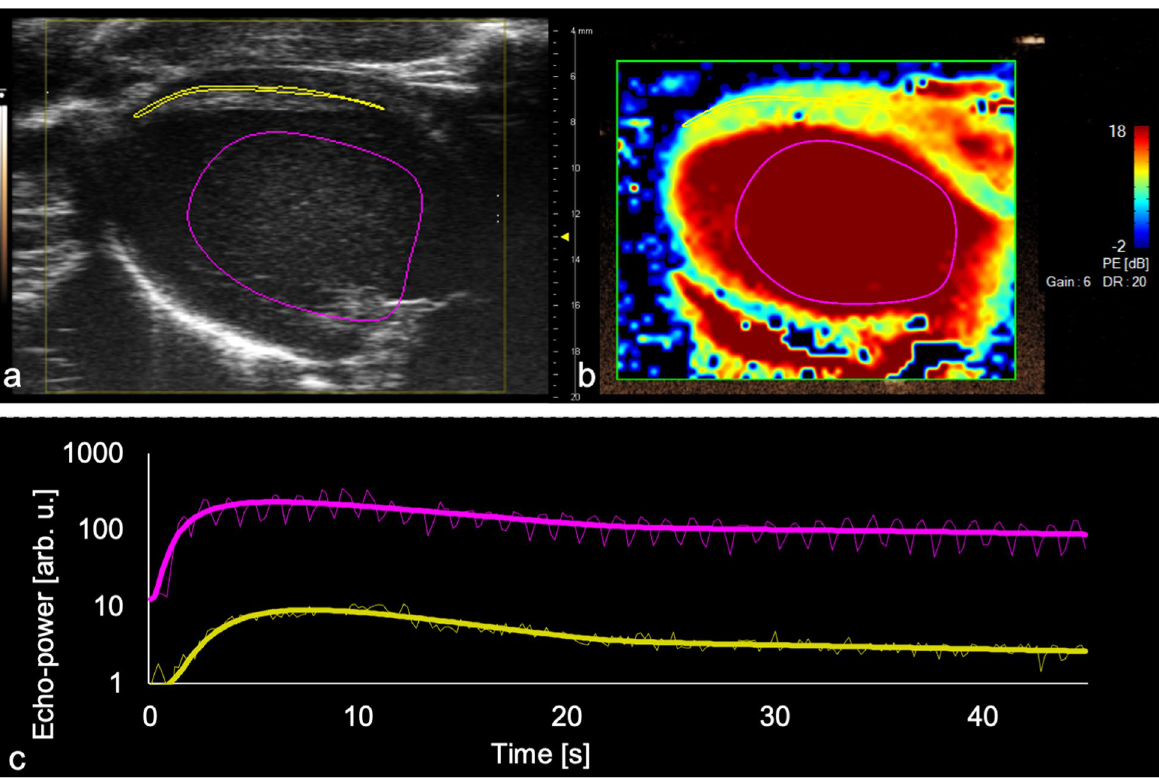
Fig. 5 Illustration of the myocardial perfusion assessment in Vevo CQ. a Placement of the ventricular region of interest (ROI, pink) and the myocardial ROI (yellow). b Parametric colour-coded image showing the peak enhancement. c Time-intensity curve of the ventricular (pink) and myocardial (yellow) ROIs on a logarithmic scale. The bold line represents the fitted perfusion model, while the thin line represents the measured data points